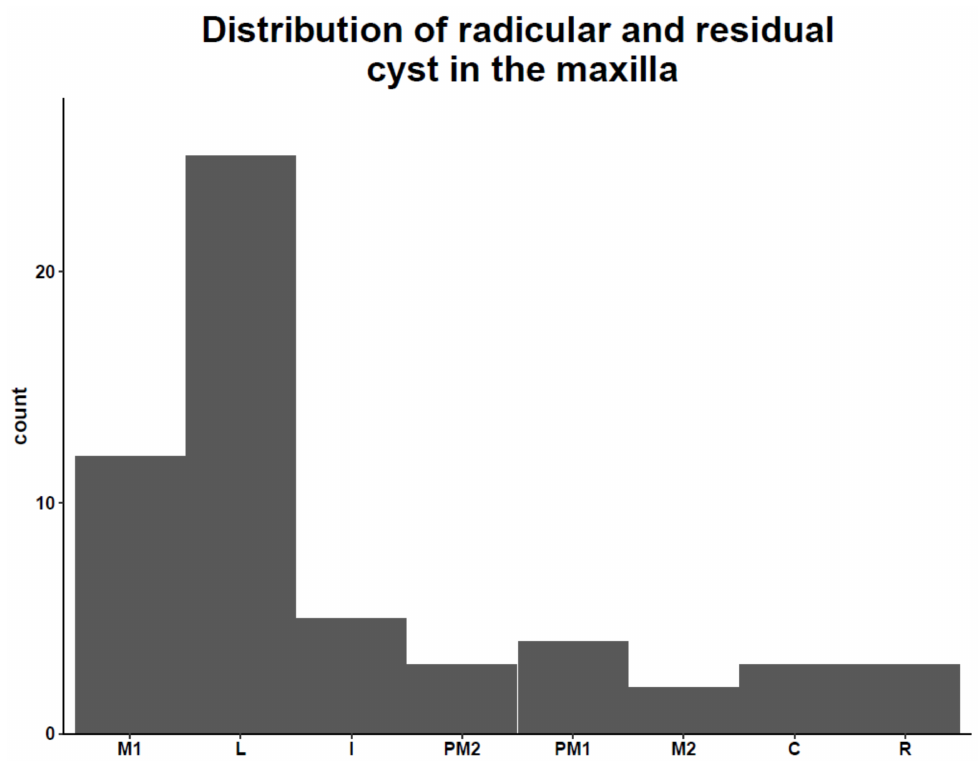
Figure 1. M1: First molar. L: lateral incisor. I: Central incisor. PM2: Second premolar. PM1 First premolar. M2: Second molar. C: canine. R: residual